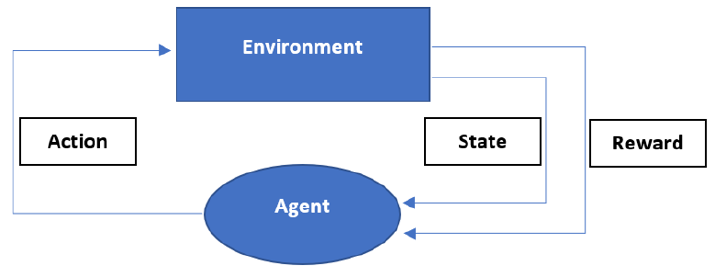
Figure 10. Environment and agent interaction.